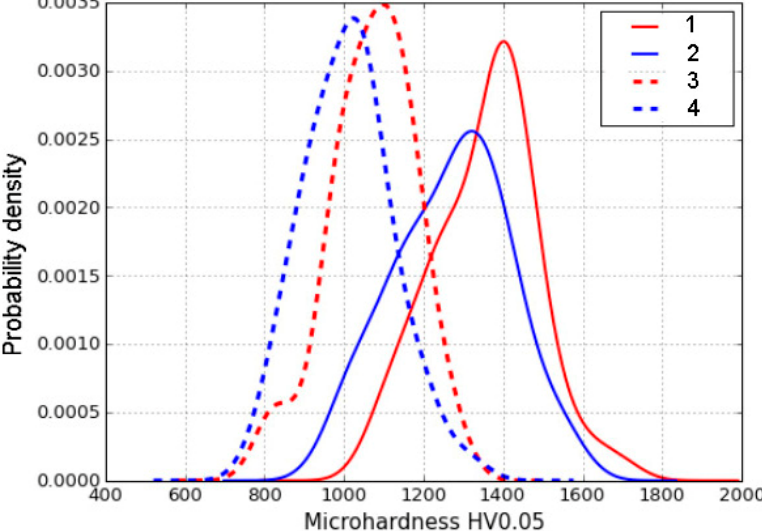
Figure 7. Distribution of worn surface microhardness for samples worn in A and B modes: 2—B1000; 3—A900; 1—B900; 2—B1000; 3—A900; 4—A1000.